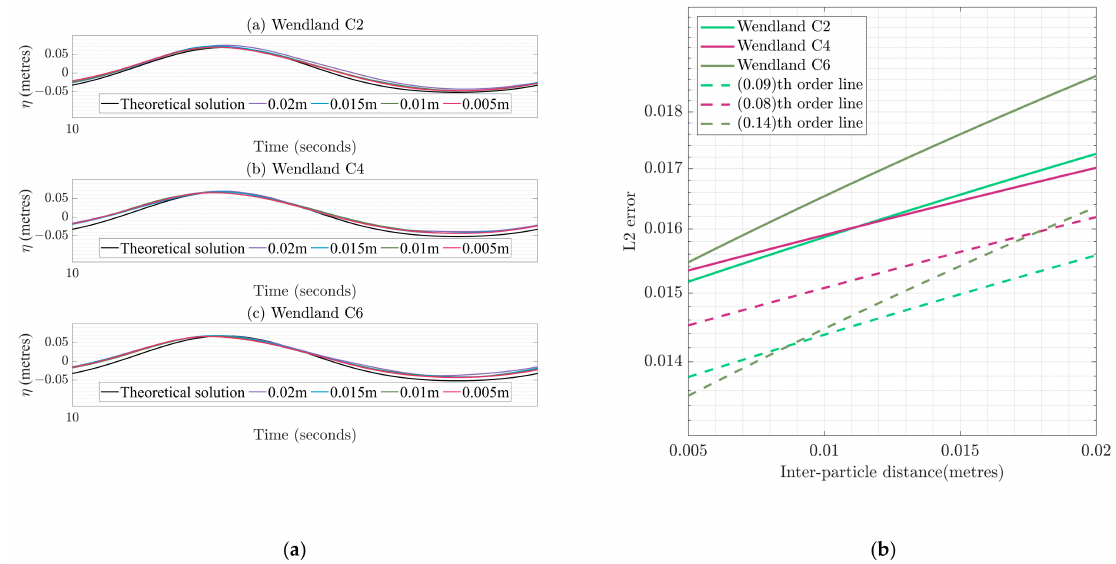
Figure 16. ( a ) Particle grid study with four different values of particle spacing for the three kernels. ∆ x 1 = 0.005 m, ∆ x 2 = 0.01 m, ∆ x 3 = 0.015 m, and ∆ x 4 = 0.02 m ( b ) The L2 error for the corresponding grid study interpolated over the range of particle resolution is shown. Table 5. Computed L2 errors for the particle resolution study using the different kernel functions. Fluid Particle Spacing ( ∆ x